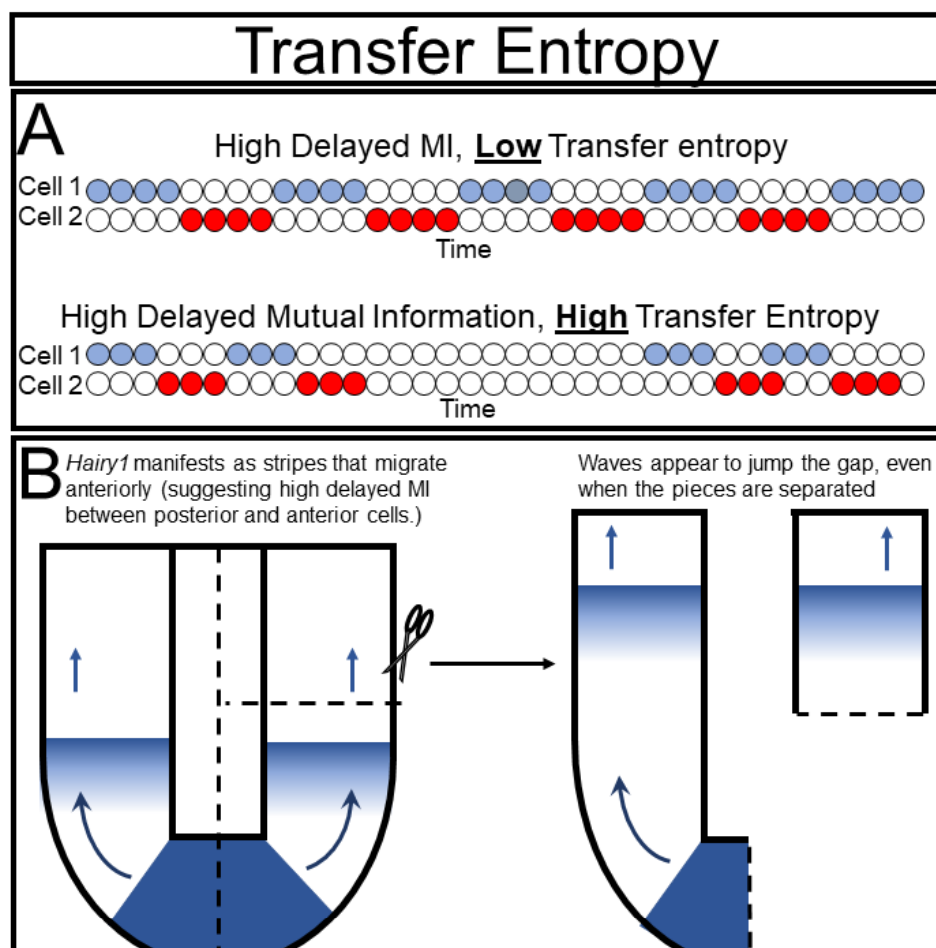
Figure 5. Delayed mutual information and transfer entropy: ( A ) Delayed mutual information measures the predictive power of one variable to another variable’s future, allowing for detection of causal interactions, whereas, transfer entropy is a more powerful approach that considers predictive power of the receiving variable’s own history, and thus, avoids inferring causation from time delayed correlative interactions; ( B ) the vertebrate segmentation clock is a biological example of the incorrect interpretations that can arise from failing to account for a cell’s history. Waves of gene expression appear to migrate posterior to anterior in the growing tail, but will form even when the apparent ” sending ” cells are ablated, indicating that they result from intrinsic oscillations within the cells.